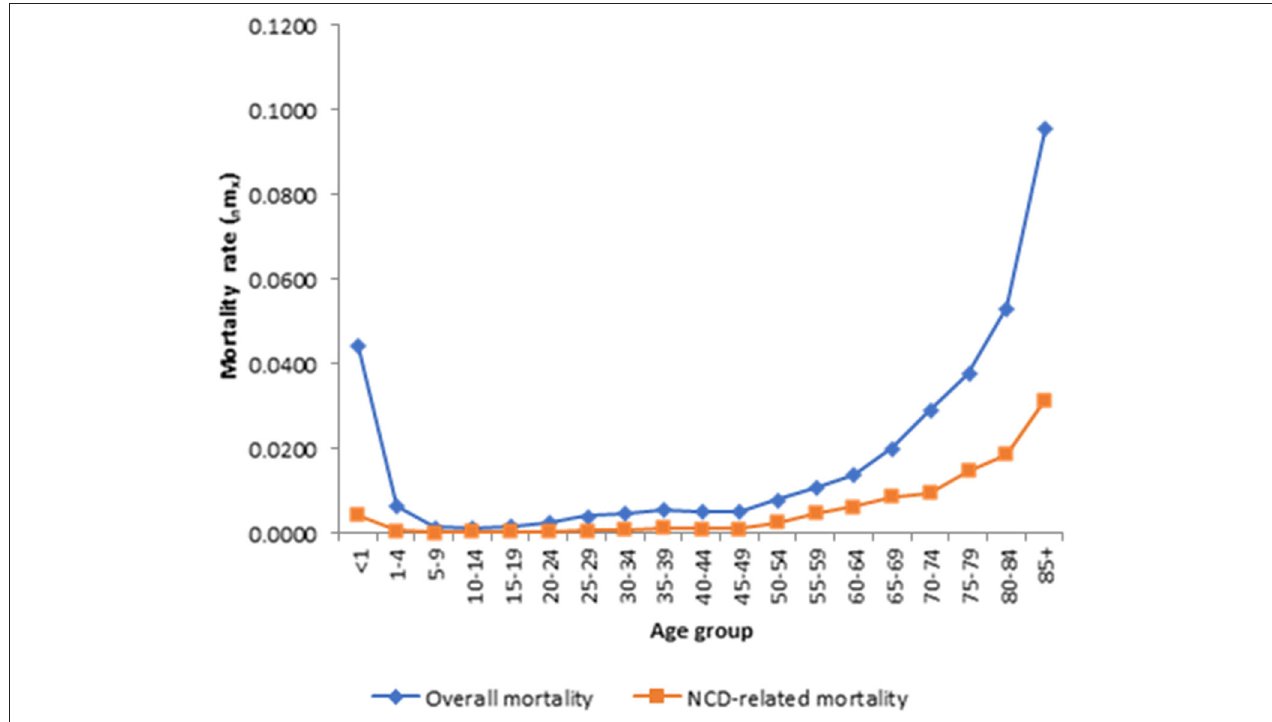
FIGURE 2 | Age pattern of infectious diseases for overall morality and infections causes-specific mortality. Source: Kintampo HDSS (2005–2014).